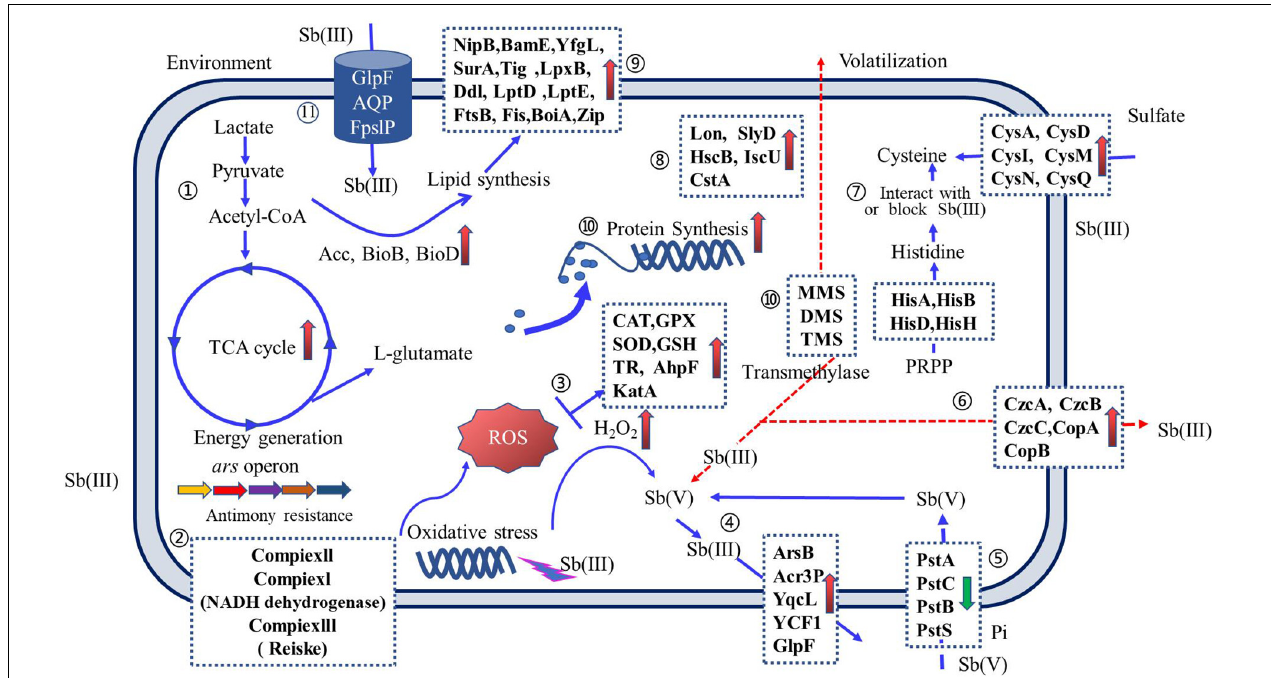
FIGURE 5 | An overview of Sb(III) resistance regulation of Sb-oxidizing bacteria. Arrows on solid blue lines ( — ) indicate the function of proteins that have been reported and validated; arrows on dashed red lines ( •••• ) indicate proposed protein functions and have not been reported elsewhere or require further validation. Up-regulated proteins (upward pink arrows) and down-regulated proteins (downward green arrow) are indicated. Pathways include the following: (cid:192) carbon metabolism; (cid:193) oxidative phosphorylation; (cid:194) reactive oxygen species (ROS) scavenging; (cid:195) Sb efflux; (cid:196) phosphate transporters; (cid:197) metallophores; (cid:198) amino acid synthesis; (cid:199) anti-stress proteins; (cid:200) cell wall formation; (cid:201) ribosomal and peptide syntheses; and (11) Sb(III) uptake (for interpretation of the references to color in this figure legend, the reader is referred to the web version of this